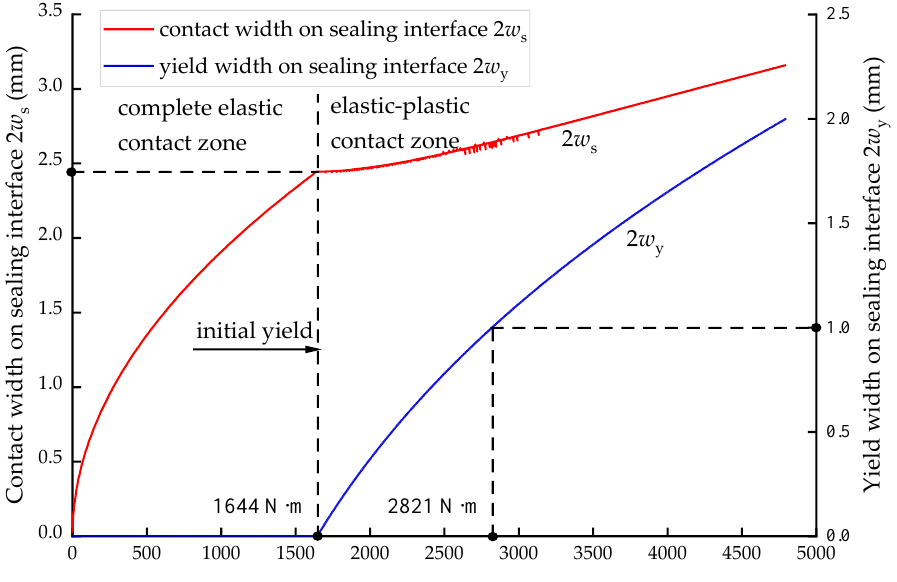
Figure 6. Effects of additional make-up torque from sealing interface on contact width and yield width on sealing interface for sphere-type premium connection.